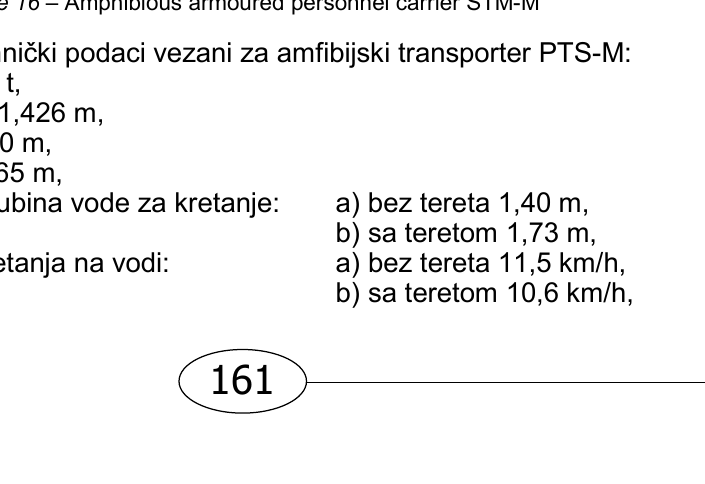
Figure 16 – Amphibious armoured personnel carrier